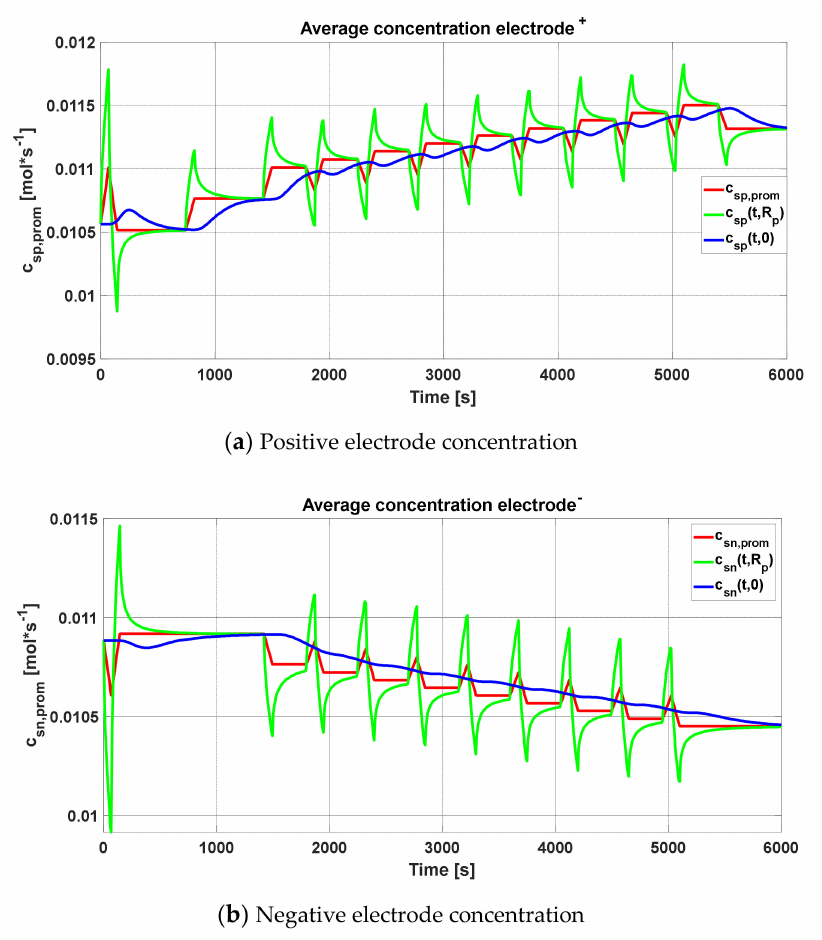
Figure 28. Averaged concentrations in the sphere volume based on the HPPC procedure: ( a ) positive electrode concentration; ( b ) negative electrode